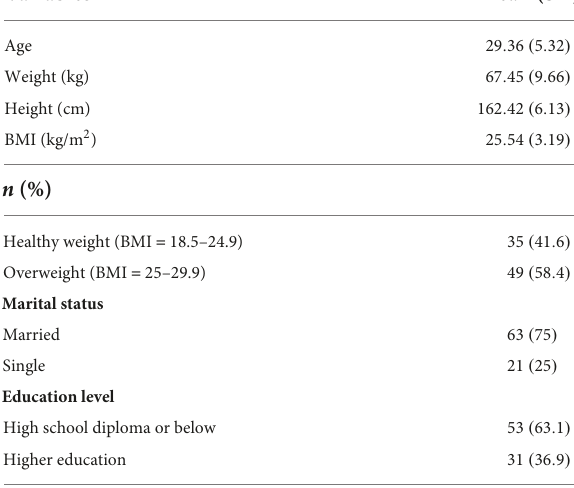
TABLE 1 Demographic characteristics of the study participants ( n =